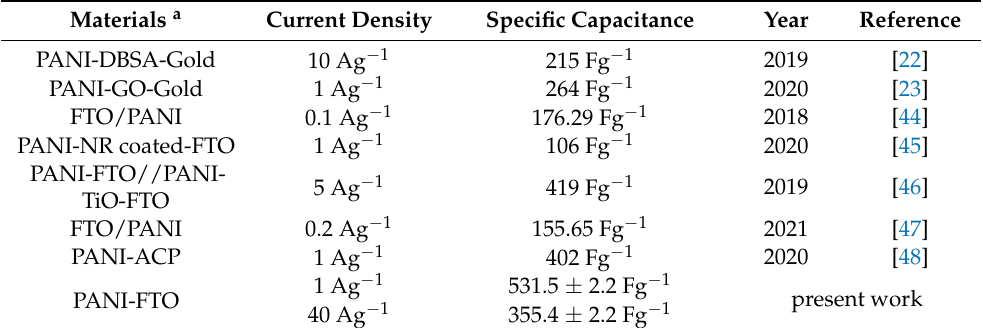
Table 3. Comparison of the specific capacitance of the symmetrical FTO-PANI supercapacitor with reported supercapacitors electrodes from the literature.